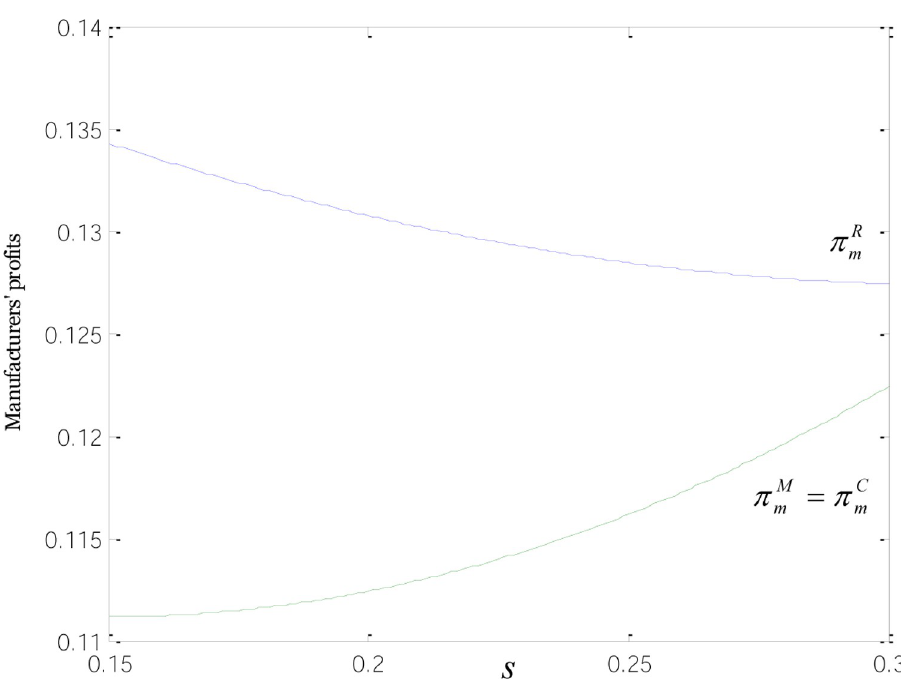
Fig 7. Relationships between manufacturers’ profits and low-carbon